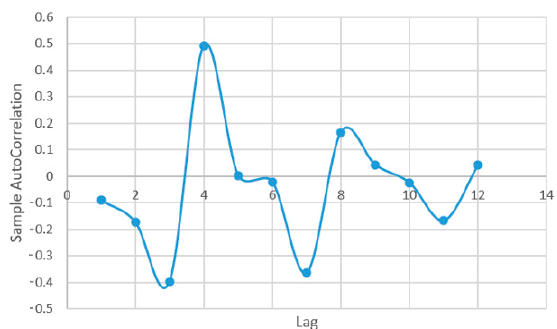
Figure A1. The AC with transformation in square roots—Series A.